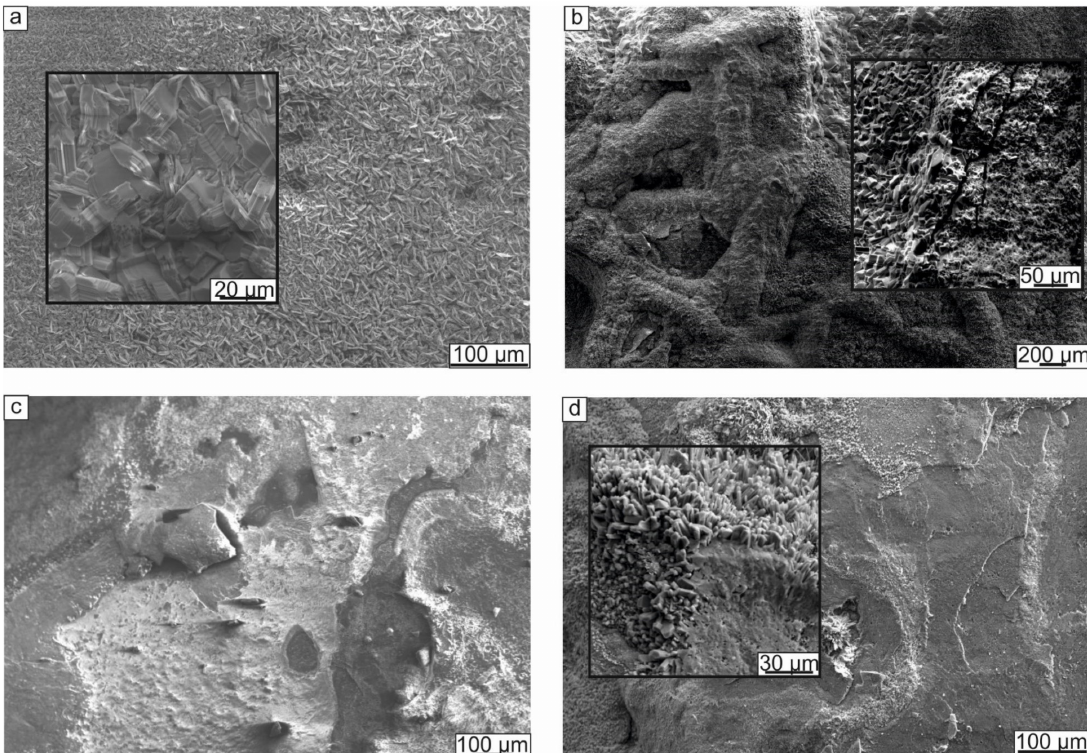
Figure 9. Oxide scales formed on the surfaces of samples after cyclic oxidation at 800 ◦ C for 200 h: pure titanium ( a ), Ti-41Al-7Cr ( b , c ), Ti-41Al-7Ta ( d ). SEM micrographs were obtained in the secondary electron